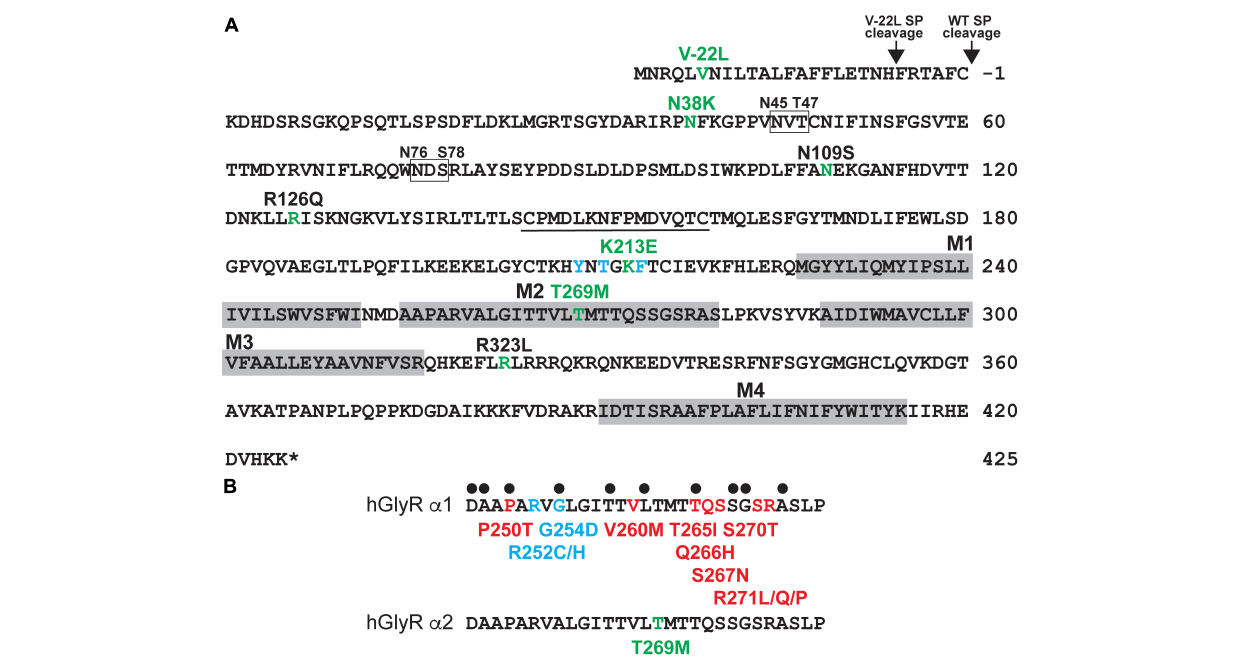
FIGURE 1 | Human GlyR α 2 subunit variants associated with ASD and neurodevelopmental disorders. (A) Human GlyR α 2 subunit missense variants p.V-22L (signal peptide), p.N38K (ECD), p.K213E (ECD), and p.T269M (M2) were identified in individuals with autism spectrum disorder (ASD) or developmental disorders (DD). Amino acid sequence of the human GlyR α 2 subunit indicating the positions of putative membrane-spanning domains (gray shaded boxes), amino-acid residues affected by missense changes associated with ASD or DD (green), key glycine-binding residues (blue), and glycosylation sites (boxes). (B) Alignment of the human GlyR α 1 and α 2 subunits showing pore-lining residues (black dots) and different types of pathogenic mutations found in the GlyR α 1 subunit in human startle disease. Red, dominant; blue, recessive; green, spontaneously opening channels (leakage current). Note that GlyR α 2 T269M does not affect predicted pore-lining residue, nor does it correspond to a position of a known GlyR α 1 subunit startle disease mutation.